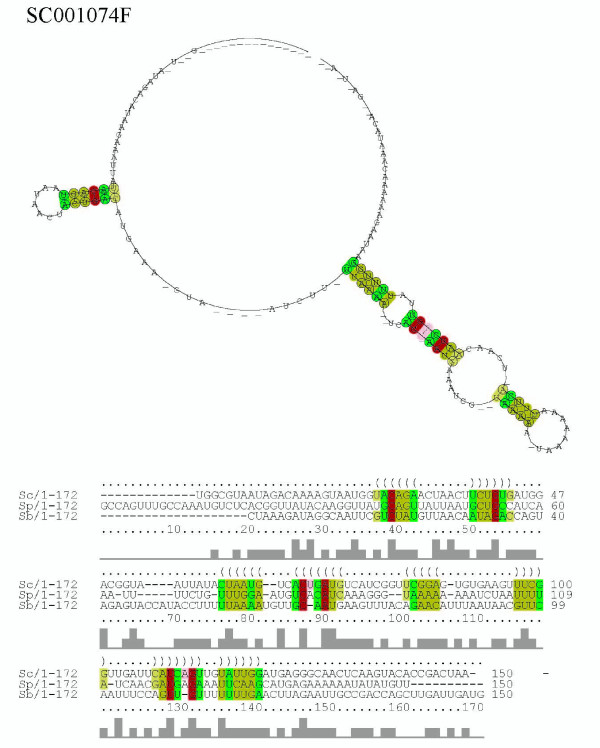
Consensus structure and alignment of ncRNA candidate SC001074F. This alignment is composed of a S. cerevisiae sequence (chr14/474,642–474,791 bp/+), a S. paradoxus sequence (c250/6,937–7,086 bp/+), and a S. bayanus sequence (c627/32,967–33,116 bp/+). The averege pair sequence identity of this alignment is 34%.